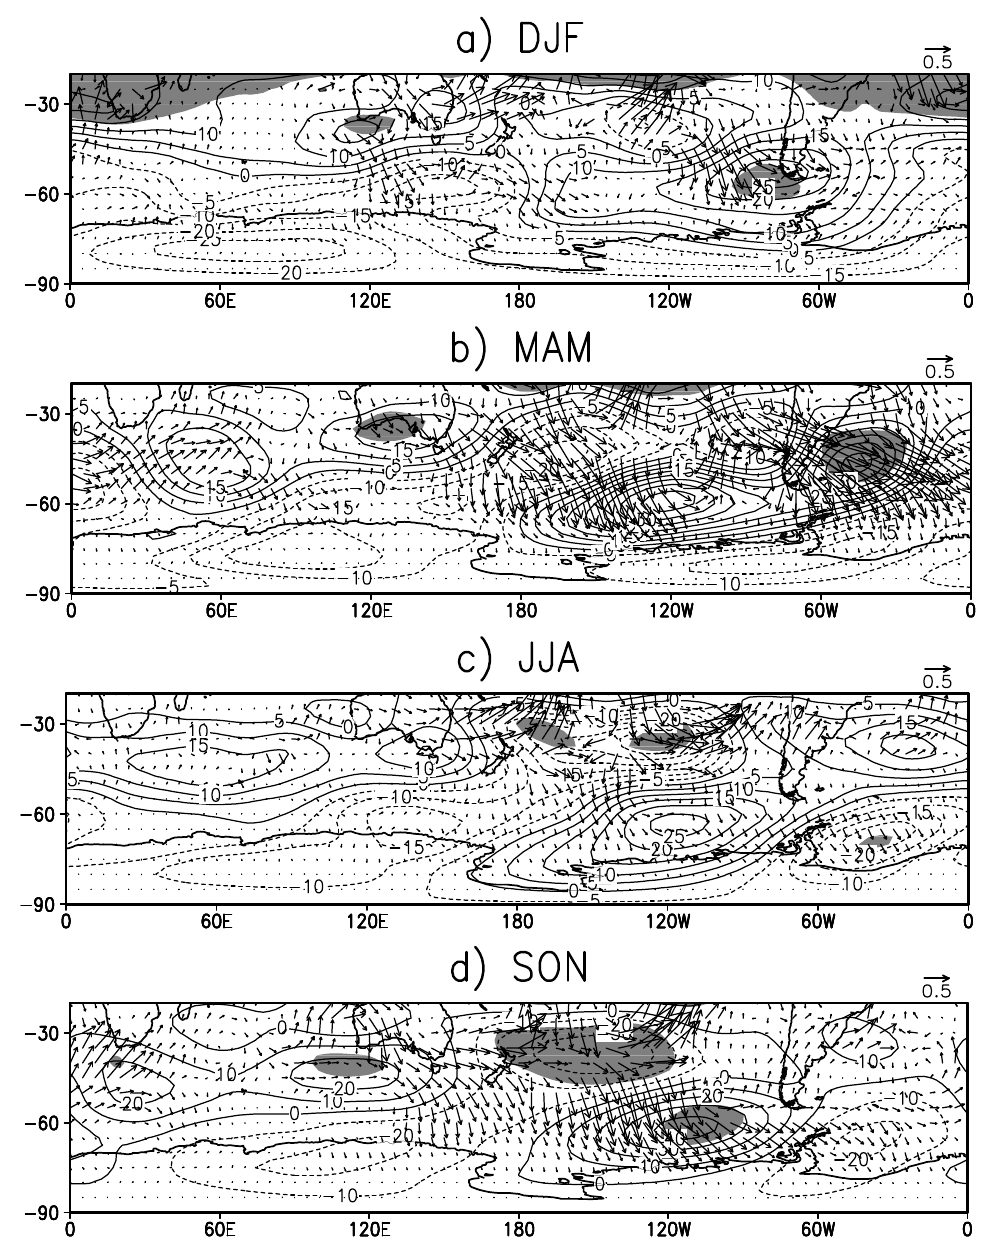
Fig. 7. Horizontal component of QS wave activity ( H c ) and geopotential height anomalies (El Ni˜no minus the mean) at 300hPa for the El Ni˜no composites for: (a) DJF, (b) MAM, (c) JJA, and (d) SON. Contour interval of height anomalies for (a), (b) and (c) is 5m, and for (d) 10m. Vectors are in m 2 s − 2